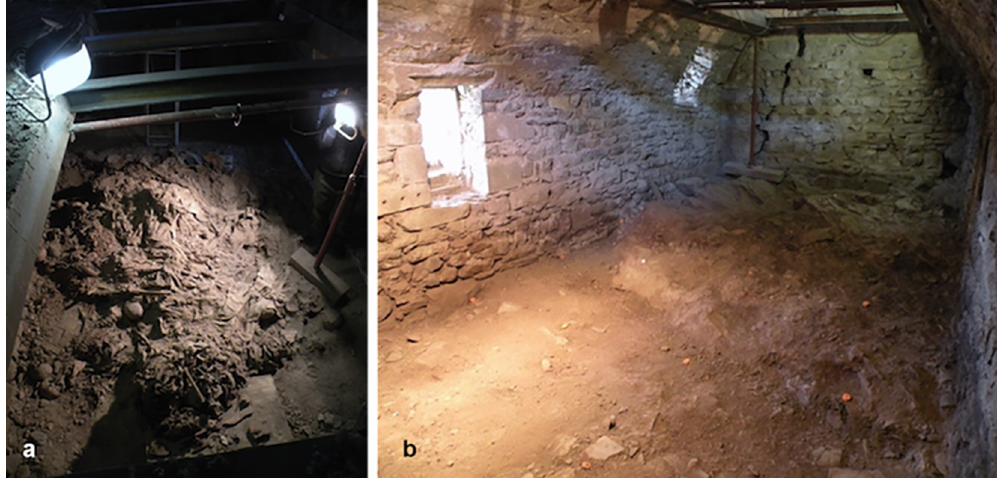
Fig 1. Bodies amassed in a pyramidal pile, at the moment of discovery in the crypt (a). Empty crypt after removing mummies. To note lateral window and floor in pure rock